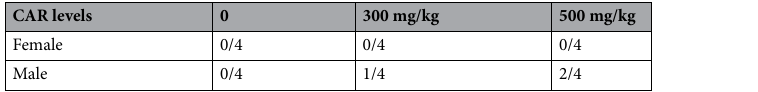
Table 3. Mortality in CAR treatment groups (dead/total). No mortality was found in the corresponding DMSO controls.